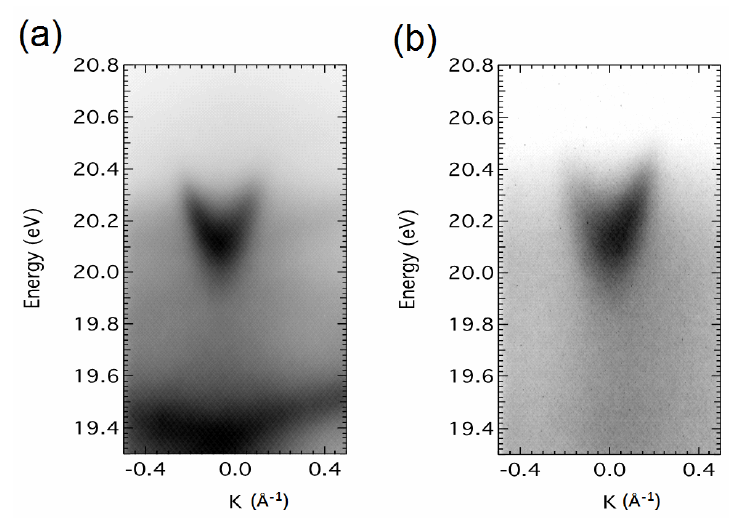
¯ Figure 12. ARPES spectra of Cu (111) band structure, along the Γ K-direction in the surface Brillouin Figure 12. ARPES spectra of Cu (111) band structure, along the  -direction in the surface Brillouin zone. ( a ) HHG EUV beam with H13 ( hv 13 = 20.15 eV); and ( b ) He-I lamp ( hv He = 21.22 eV). Vertical zone. ( a ) HHG EUV beam with H13 ( ℎ  = 20.15 eV); and ( b ) He-I lamp ( ℎ  = 21.22 eV). Vertical axis: PE energy (eV) and horizontal axis: electron K-vectors (Å − 1 axis: PE energy (eV) and horizontal axis: electron K-vectors (Å −1 ).